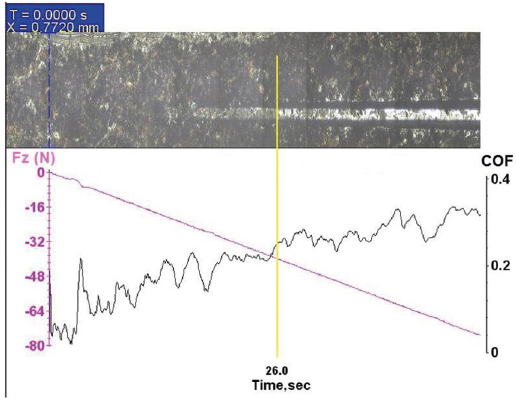
Figure 5. Graphical representation of the critical load (Fz) value.